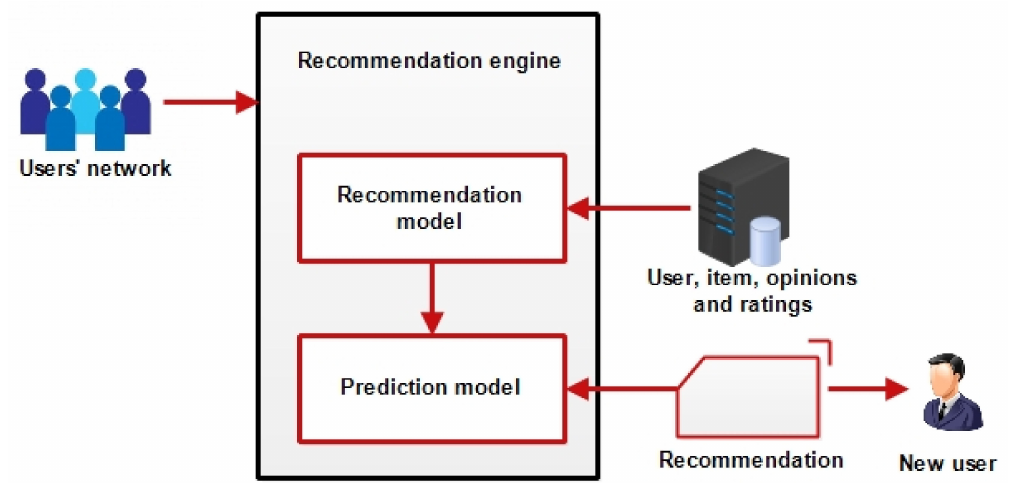
Figure 2. Adapting traditional filtering and matrix factorization algorithms typically with machine learning algorithms to build learning prediction models.